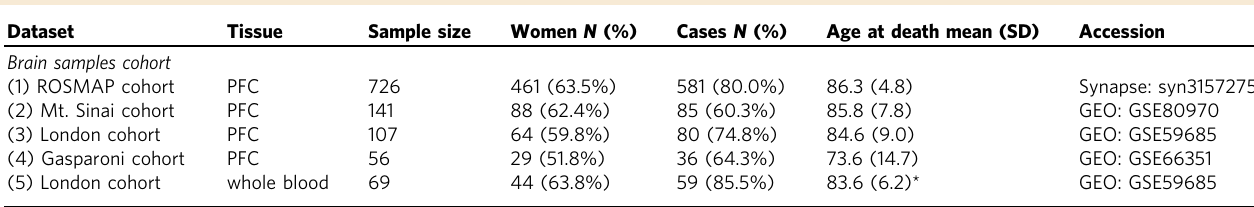
Table 1 Sample characteristics of the brain and blood cohorts included in the meta-analysis.